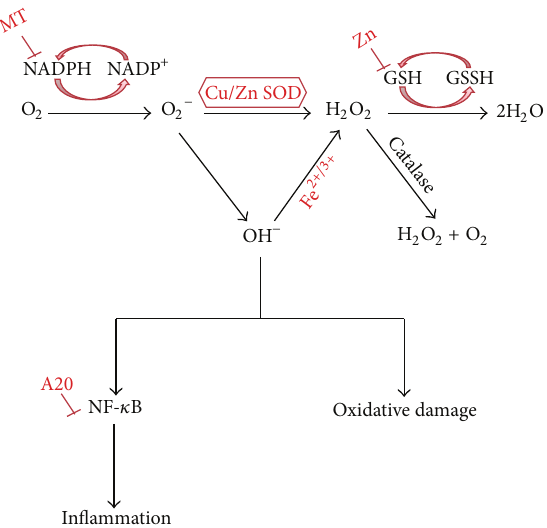
Figure 1: Proposed mechanism of zinc effect on oxidative stress and inflammation. Zinc attenuates oxidative damage and inflammation via MT, Cu/Zn SOD, Zn-finger protein, and